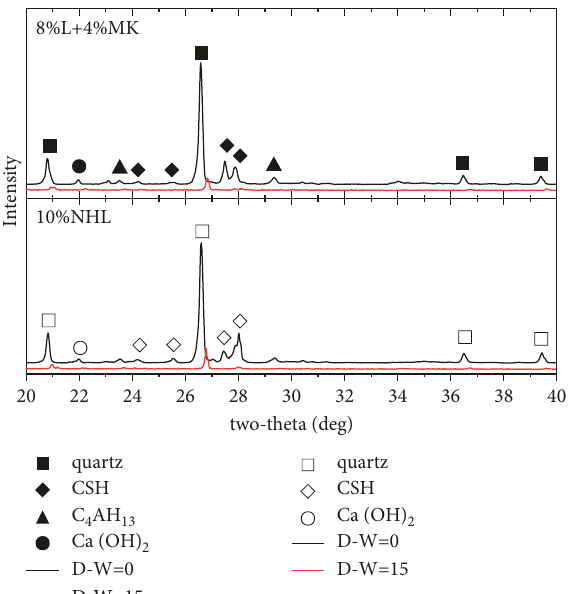
Figure 11: XRD results of hydration products of L-MK- and NHL-modified soils before and after dry-wet cycles (20 ° ∼ 40 ° ).